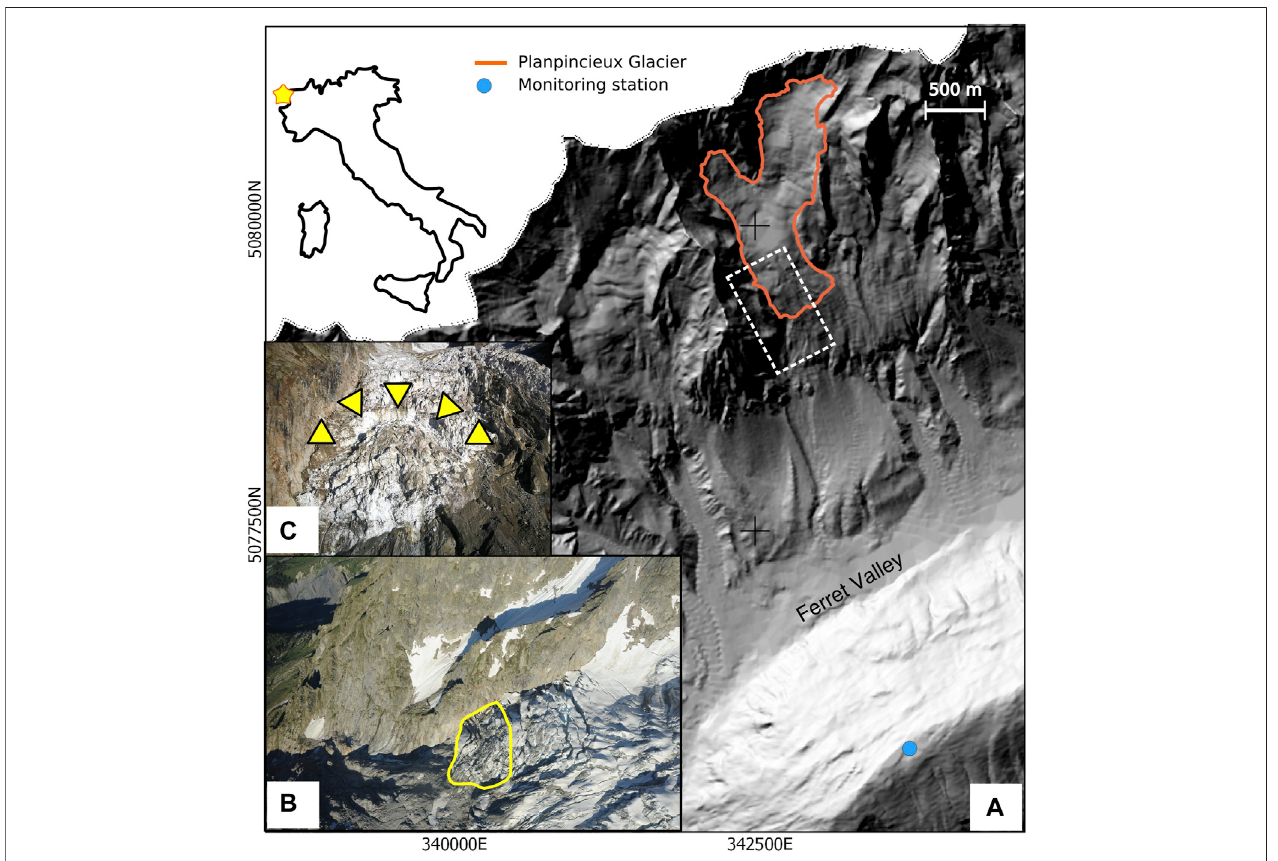
FIGURE 1 | (A) Overview of the study area, located in North-west Italy. The Planpincieux Glacier outlines are of 2019. The dashed white rectangle denotes approximately the portion shown in panel b. (B) Aerial view ofthe Montitaz Lobe in July 2020. The unstable portion is delimited in yellow. (C) Frontal view ofthe Montitaz Lobe ’ s terminus in October 2019. Yellow triangles indicate the wide transversal crevasse above the unstable portion.